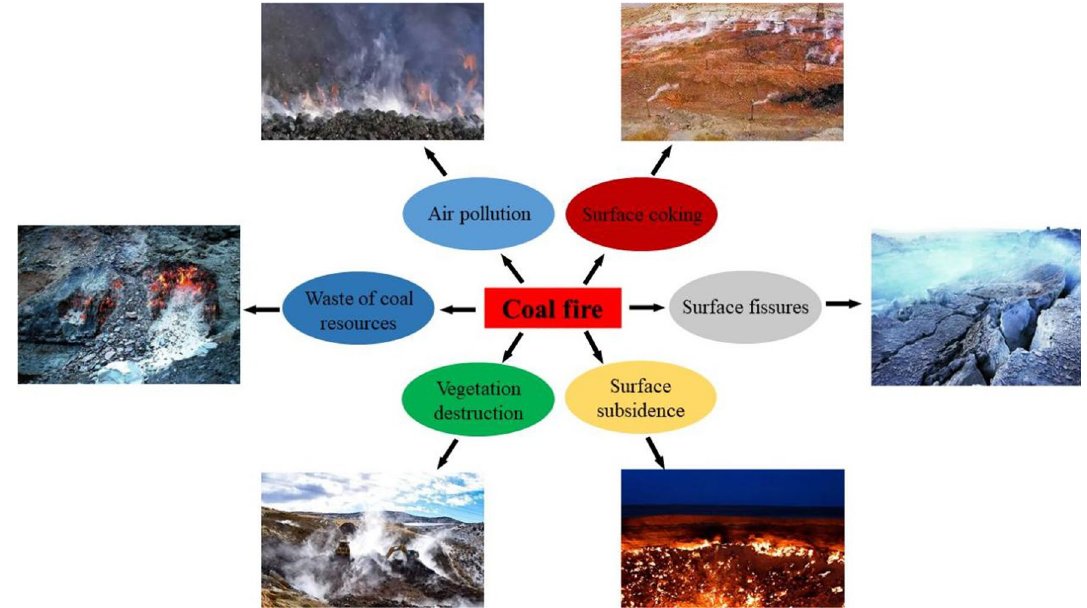
Fig. 1 Diagram of coal fire